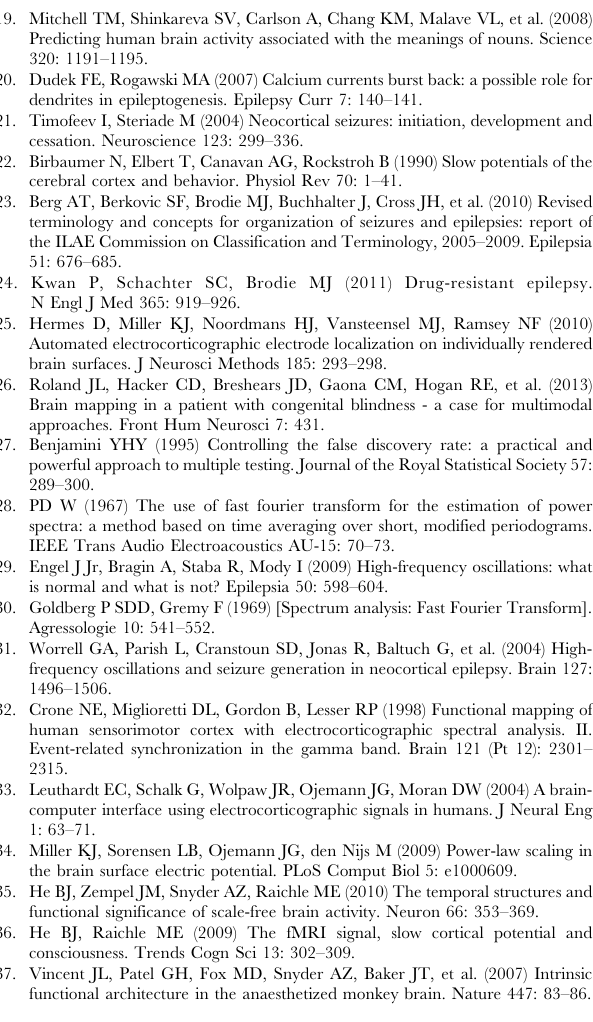
Figure S1 Comparison of clinical and research covari- ance topographies. Exemplar cortical surface topography for a 20 minute interictal epoch aquired for clinical purposes (A) using a Natus differential amplifier (Natus Medical Incorporated, San Carlos, CA, USA) which includes a 0.5 Hz hardware filter and a 20 minute interictal epoch acquired for research purposes (B) using a g.USBamp amplifier (g.tec, Graz, Austria) which includes no hardware or software